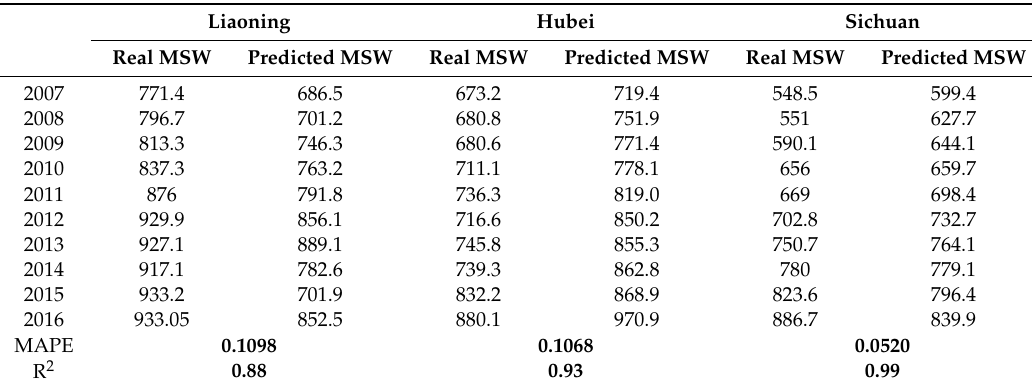
a MAPE—Mean Absolute Percentage Error. (Units: ten thousand